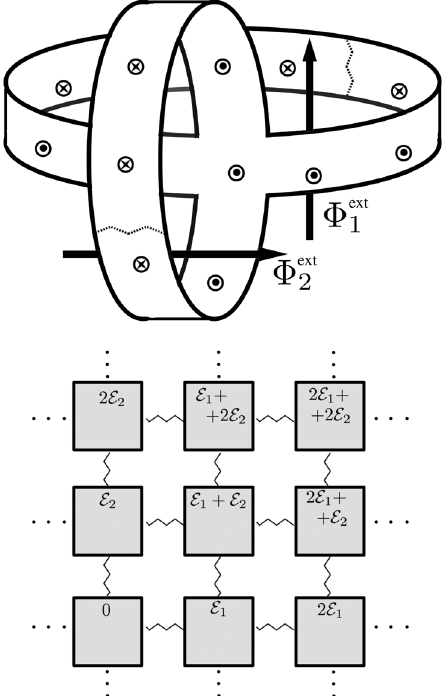
FIG. 14. Top: Two-loop, nonplanar Hall conductor for realizing an inductively coupled gyrator. The magnetic field texture necessary to produce the Hall effect in this conductor is shown; threading fluxes Φ ext 1 and Φ ext 2 can apply electromotive forces E ¼ _ Φ ext around the two loops. Bottom: Periodic representation i i of a conductor, in which the loops are unwrapped at the wavy lines in the top figure. The solution to the field problem for Hall ¼ π = 2 is given by setting the boundaries of this angle θ H structure to the equipotentials indicated, which linearly increase from cell to cell as determined by the two emfs E 1